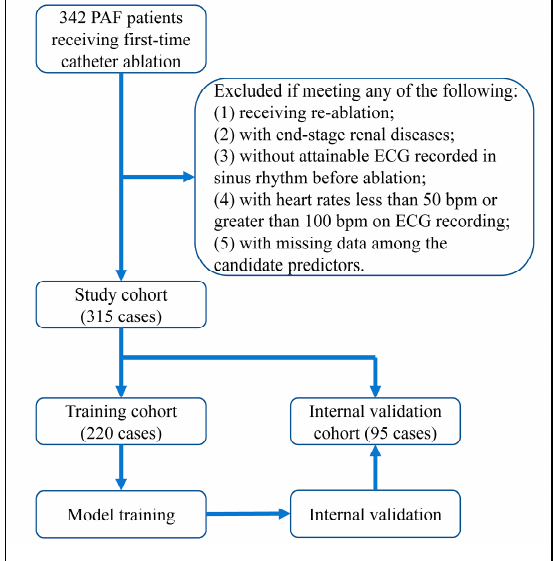
Figure 1. Flowchart of the